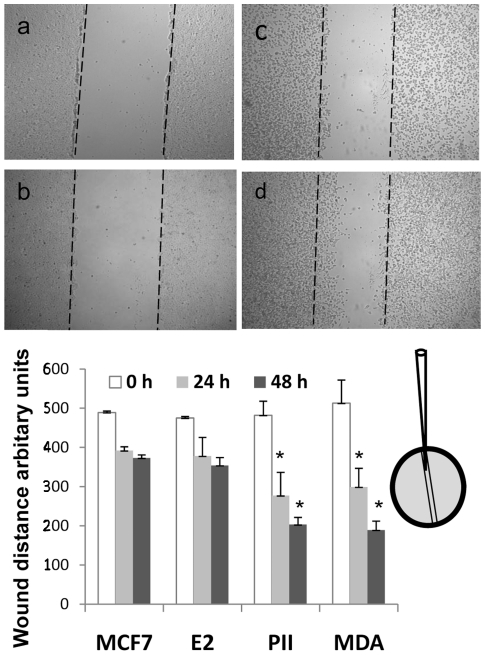
Motility assay of MCF7, pII and MDA231.Cells were plated into individual wells of a 6 well microwell dish and allowed to grow to ∼80% confluency. A scratch was made across the centre of the cell monolayer with a yellow eppendorf pipette tip (as shown in cartoon) creating a parallel space. Damaged cells were removed by carefully aspirating off the medium and rinsing with PBS before addition of fresh medium containing 2% serum. Upper panels show comparative microscopic view of MCF7 (a–b) and pII (c–d) cells in the scratched area at 0 time (a, c) and after 24 h [b, d] for a typical experiment. Chart shows the combined quantitated results from 3 independent experiments for the cell lines indicated. Histobars represent the mean [± standard deviation] width of the original scratch space at 0, 24 and 48 h. Wound closure indicates movement of cells into the scratch. *Significantly different from MCF7 cells at respective times with p≤0.006.